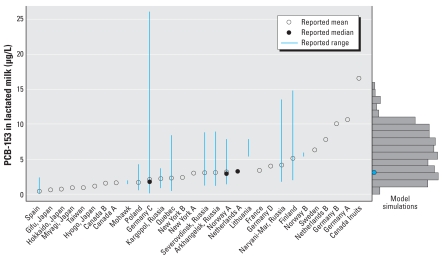
Histogram of model simulations (right) compared with global measurements of PCB-153 in breast milk (left). The uncertainty in the model predictions results from uncertainty in the daily PCB-153 intake and in milk lactation rate. The blue circle in the model simulation bar chart indicates the mean prediction. Data from Abraham et al. (1998), Germany; Angulo et al. (1999), Spain; Dewailly et al. (1994), Canadian Inuits; Glynn et al. (2001), Norway; Greizerstein et al. (1999), Canada A and B, Mohawk, Quebec, New York A and B, Netherlands A and B, Lithuania, France, Norway B, Germany A and B; Inoue et al. (2006), Japan; Jaraczewska et al. (2006), Poland; Patterson et al. (1994), Sweden; Polder et al. (2003), Russia; Vartiainen et al. (1997), Finland; and Wittsiepe et al. (2007), Germany C.